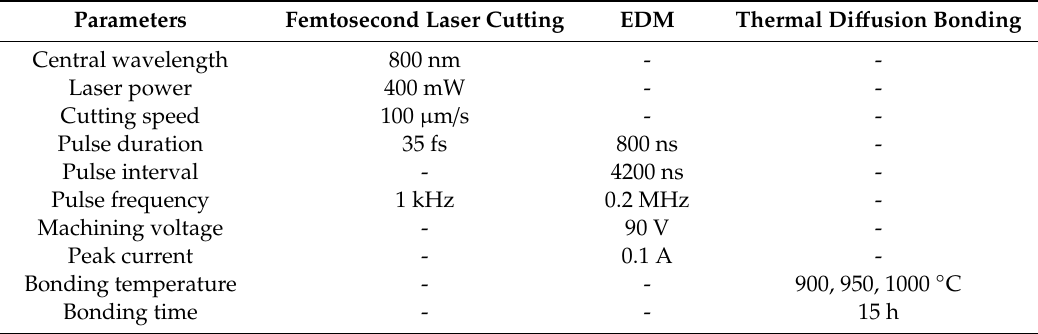
Table 1. Machining conditions for femtosecond laser cutting, EDM and thermal diffusion bonding. Parameters